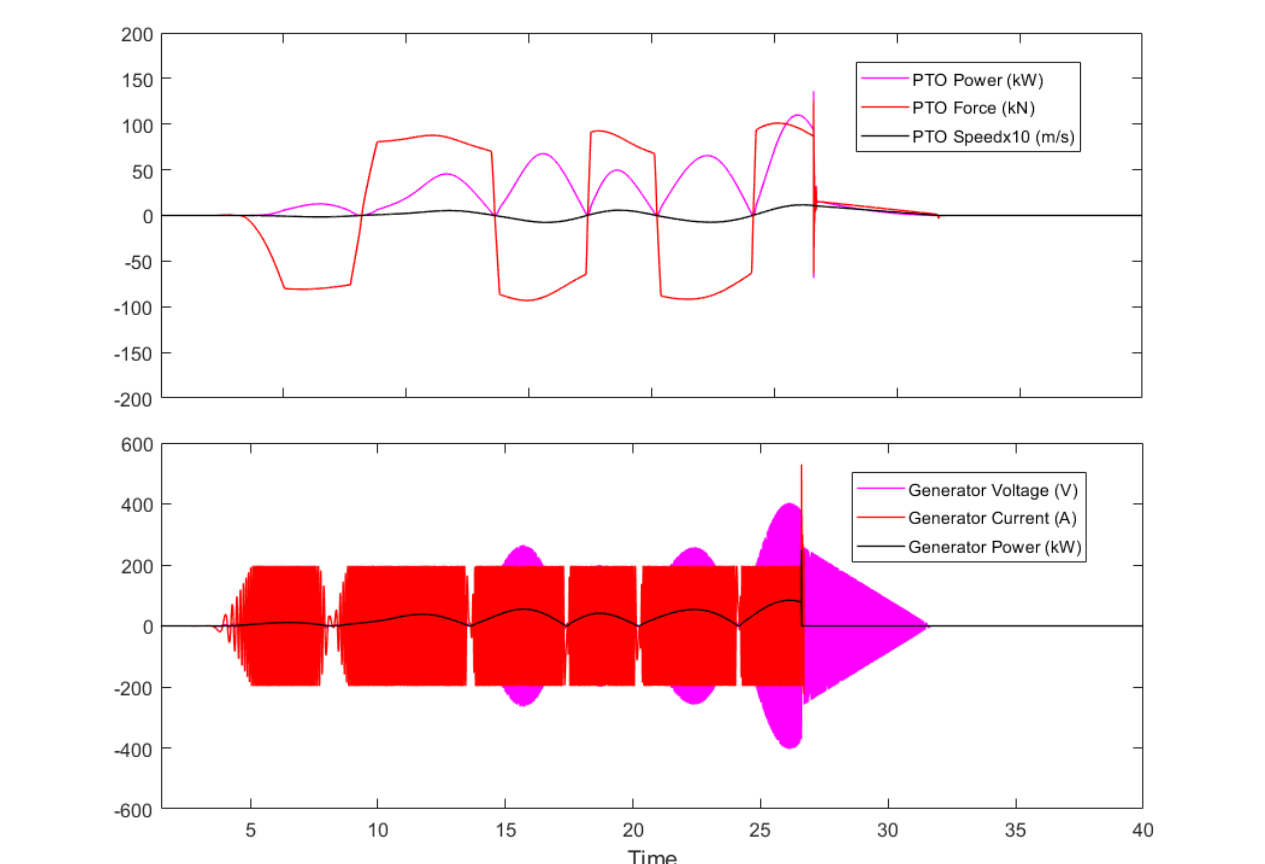
Fig. 8. Relevant mechanical (top) and electrical (bottom) signals of the generating EMU using configuration 2 when a fault occurs.